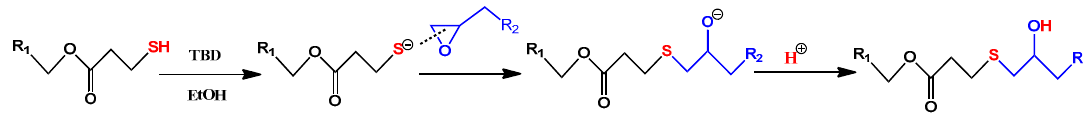
Scheme 1. Schematic diagram of thiol-epoxide click reaction catalyzed by